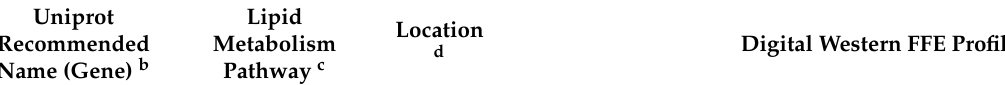
Table 8. Digital western FFE profiles of lipid metabolism-related proteins a .